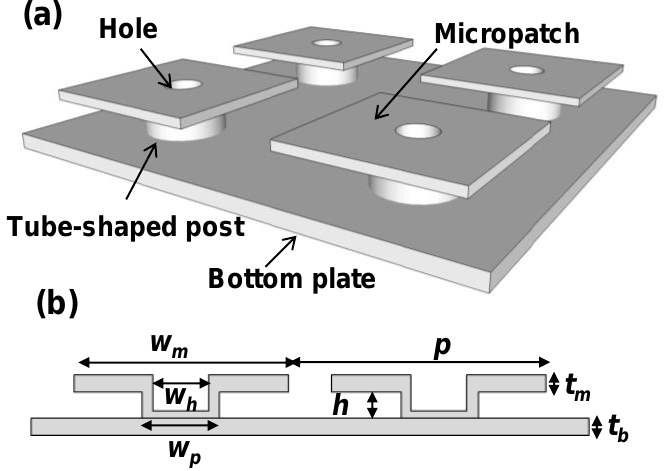
Figure 1. ( a ) Schematic diagram and ( b ) cross-sectional view of proposed mushroom plasmonic metamaterial absorber with tube-shaped metal post (MPMAT).